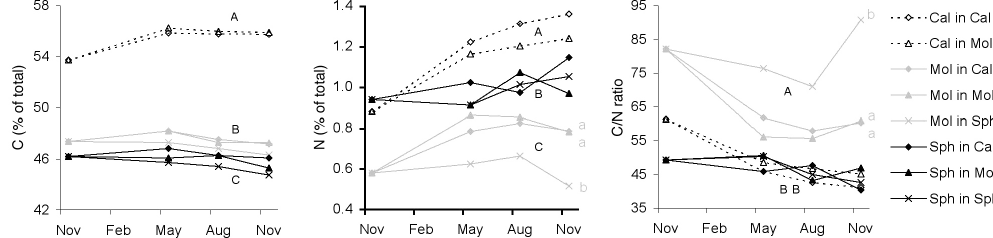
Figure 4. Carbon and nitrogen concentrations and C / N ratio in decaying biomass in the litterbags as a function of time for different combinations of litter and vegetation cover. “Cal in Cal” means Calluna litter decomposing in soil under Calluna , “Cal in Mol” means Calluna litter decomposing under Molinia , and so on. Upper-case letters indicate significant differences ( p < 0.05) between different litters, whereas lower-case letters indicate significant differences between same litters decomposing in soils covered by different types of